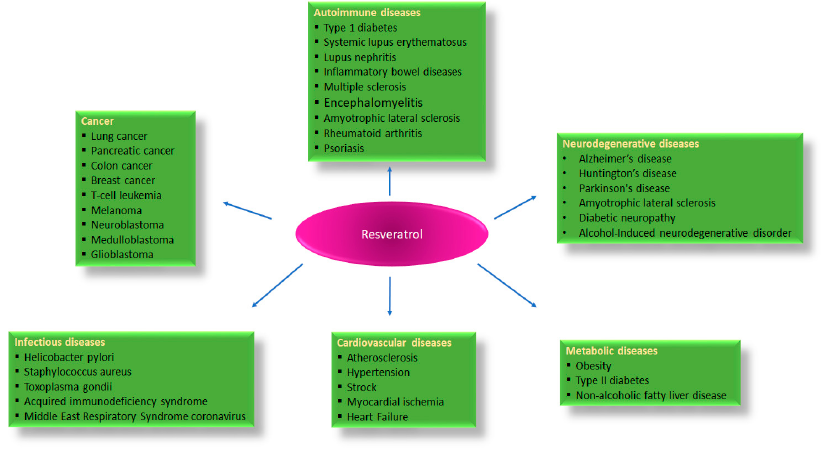
ff erent human diseases based on experimental Figure 1. Activity of resveratrol against different human diseases based on experimental studies. Figure 1. Activity of resveratrol against di